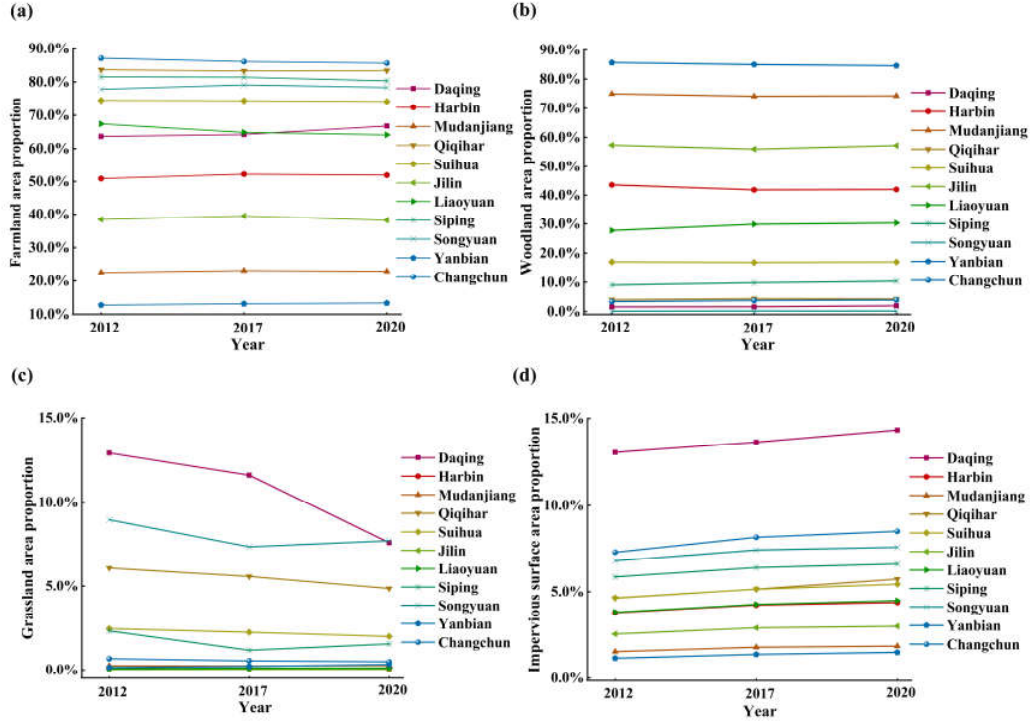
Figure 10. ( a ) The temporal variations of farmlands, ( b ) woodlands, ( c ) grasslands, and ( d ) impervious surfaces in each city from 2012 to 2020.